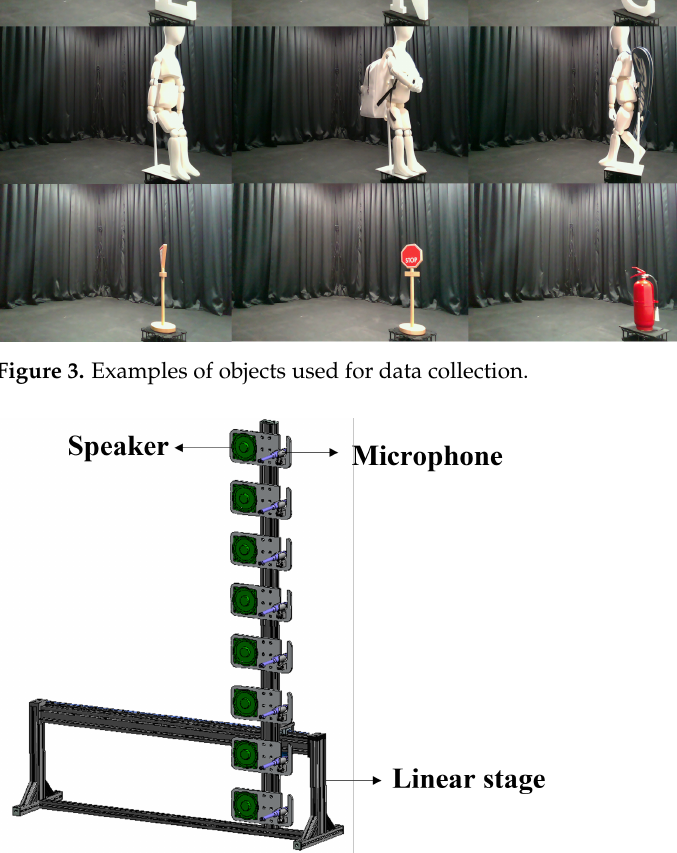
Figure 4. Illustration of our linear stage: a speaker and microphone arrays arranged